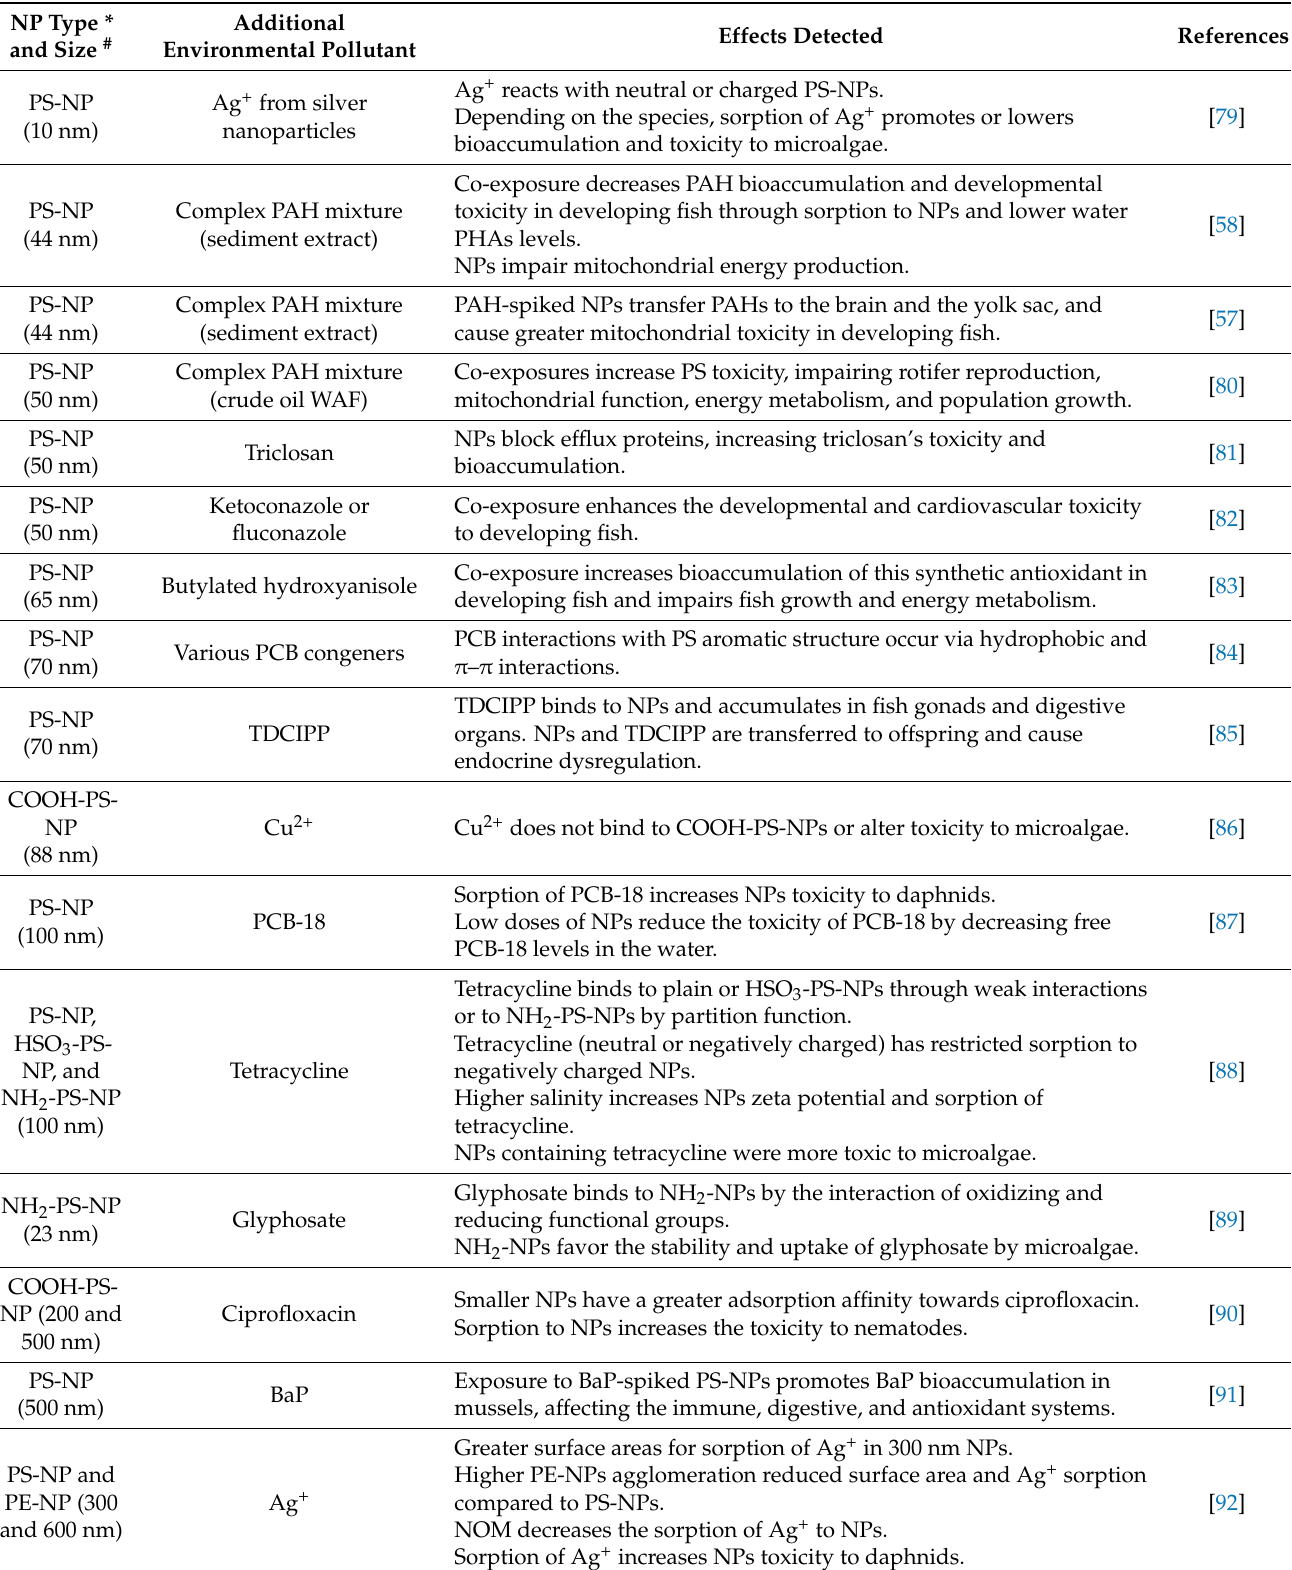
Table 1. Summary of the interactive effects of nanoplastics (NPs) and other environmental